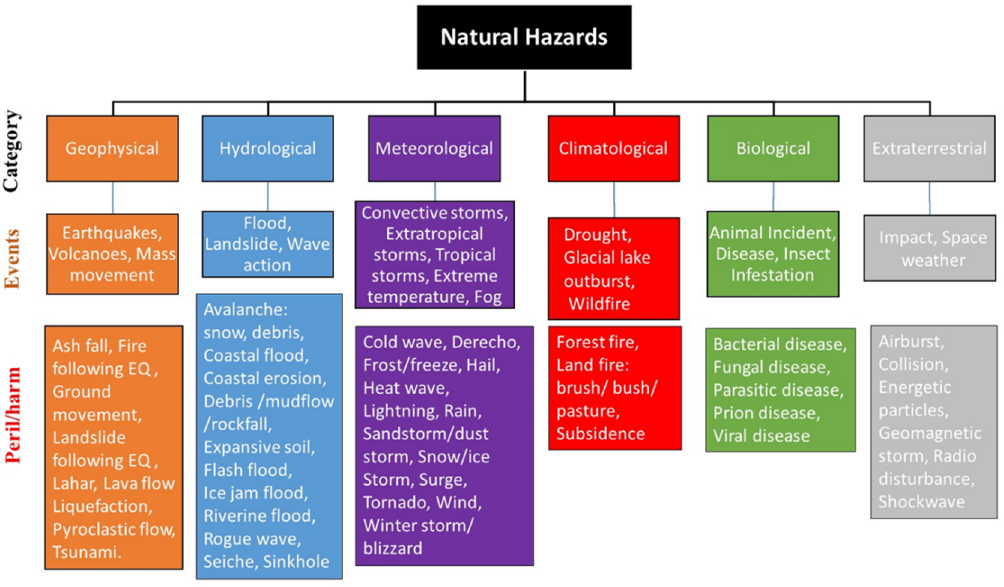
Figure 1. Classification of natural hazards with examples of events and peril/harm for each category.